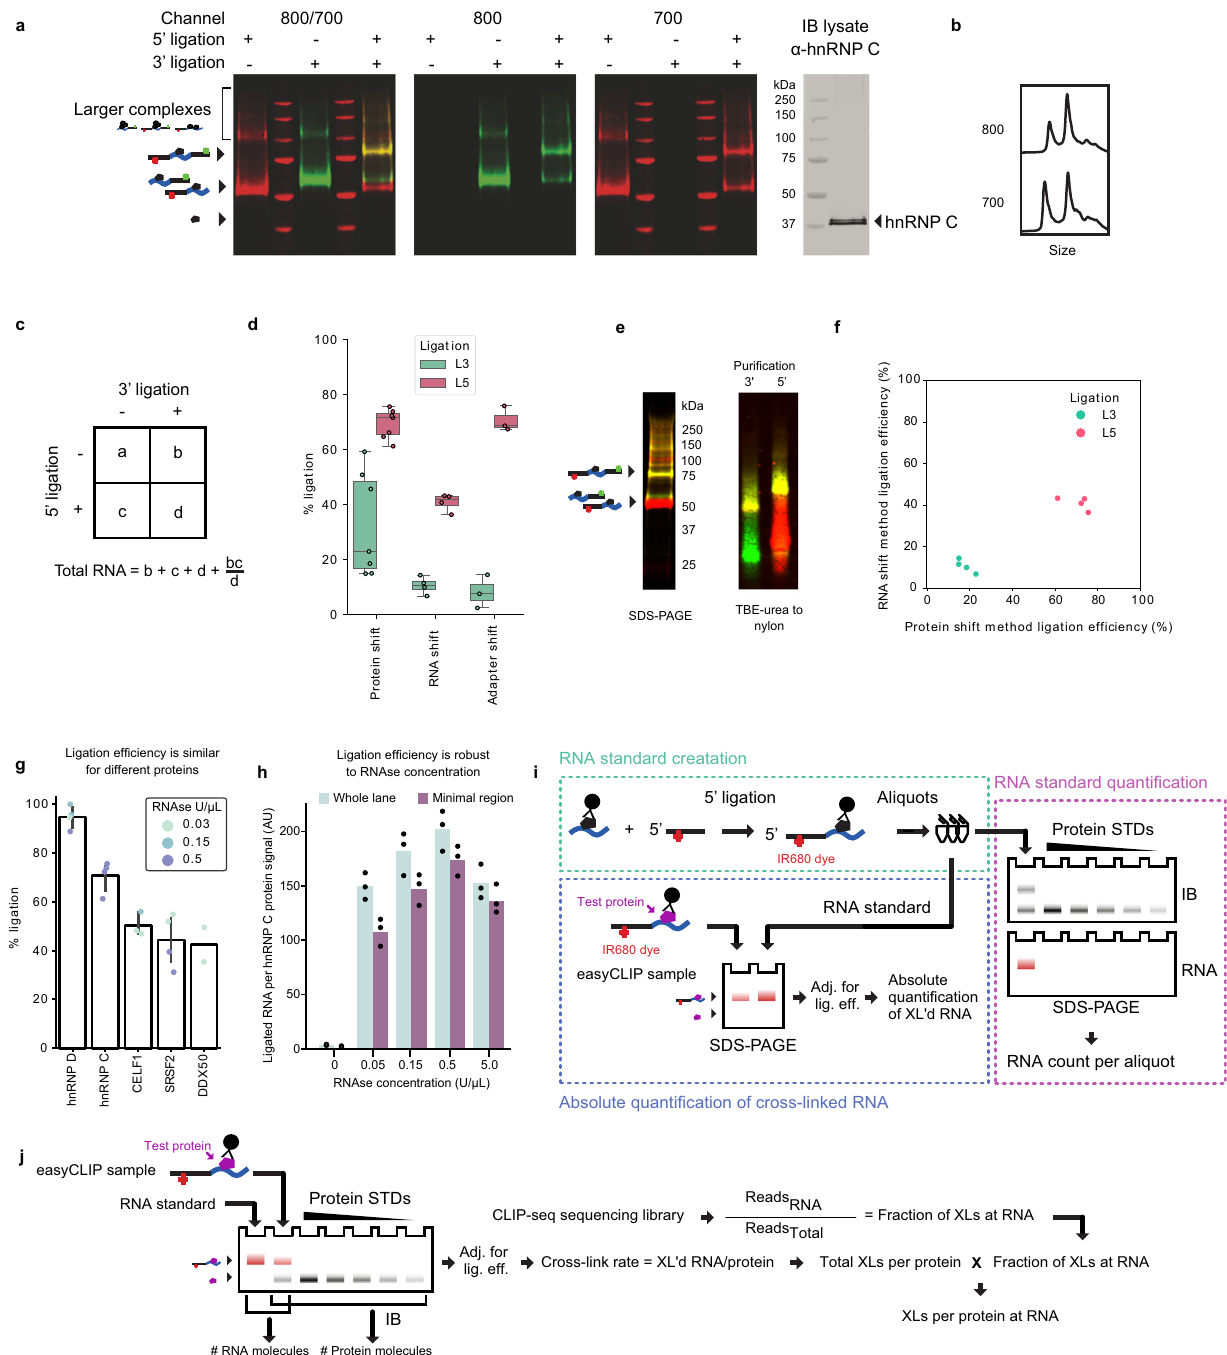
weight bands on nitrocellulose, due to variation in cross-linked protein, were collapsed into two simple fl uorescent smears, corre- sponding to mono-ligated and dual-ligated RNA (Fig. 4e). The logic of Fig. 4a – c was applied to the protein-free RNA in Fig. 4e to estimate ligation ef fi ciencies, which were lower but also consistent between replicates (Fig. 4d, f). Because the shifted bands in Fig. 3g have a 1:1 ratio of L: α L oligonucleotides, quantifying antisense oligonucleotides also quanti fi ed their respective adapters. The development of an antisense oligonucleotide-based method to quantify low femtomole amounts of adapter necessitated optimi- zation (Supplementary Figs. 12 and 13). For example, diluent had effects on fl uorescence (Supplementary Fig. 12) and there was a NATURE COMMUNICATIONS| (2021) 12:1569